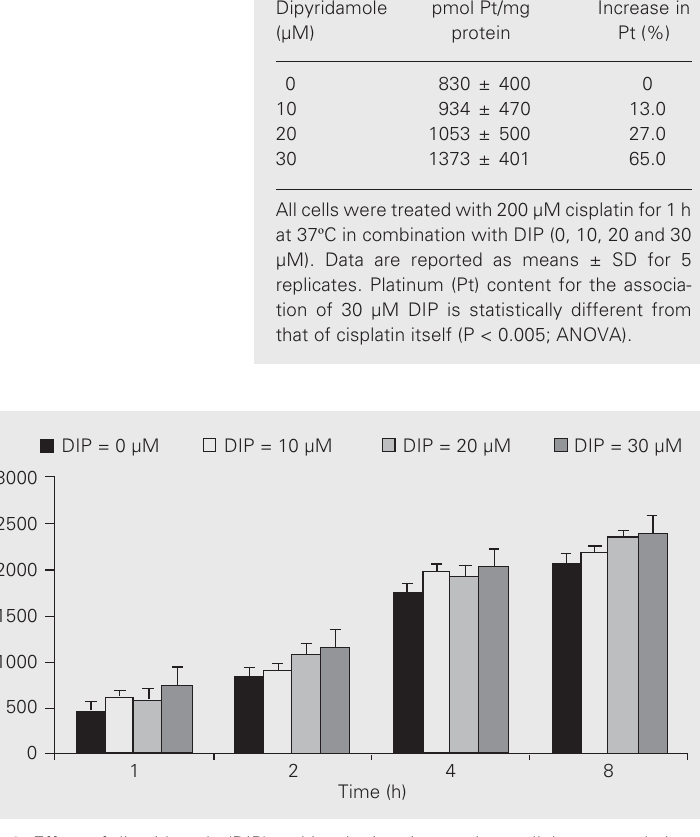
Figure 3. Effect of dipyridamole (DIP) and incubation time on intracellular accumulation of cisplatin in the human larynx tumor cell line HEp-2 at 37 º C and 5% CO 2 . Data are reported as means ± SD for 5 replicates. Platinum (Pt) content for each incubation time was statistically different (P < 0.005) from that of 1 h of